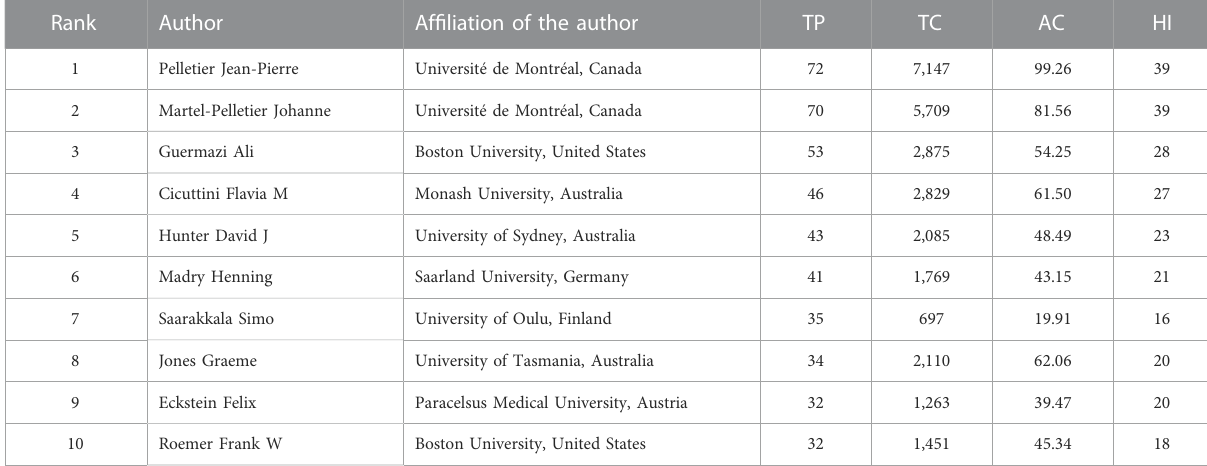
TP, total number of publications; TC, total number of citations; AC, average number of citations; HI, hirsch index.